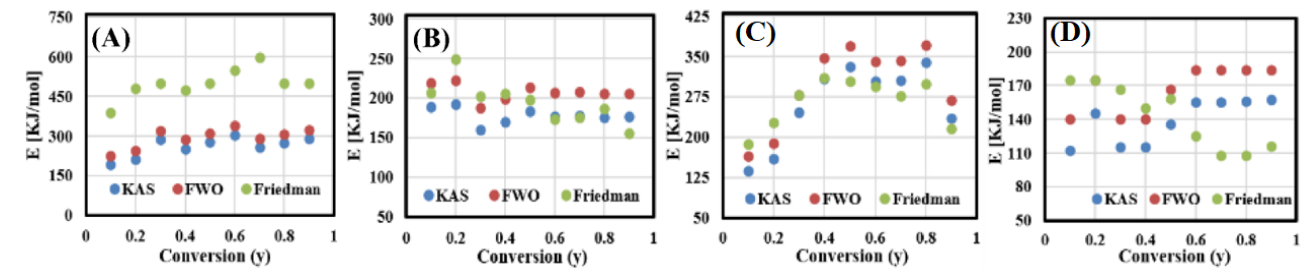
Figure 5. Plots of isoconversional and model-free methods curves.